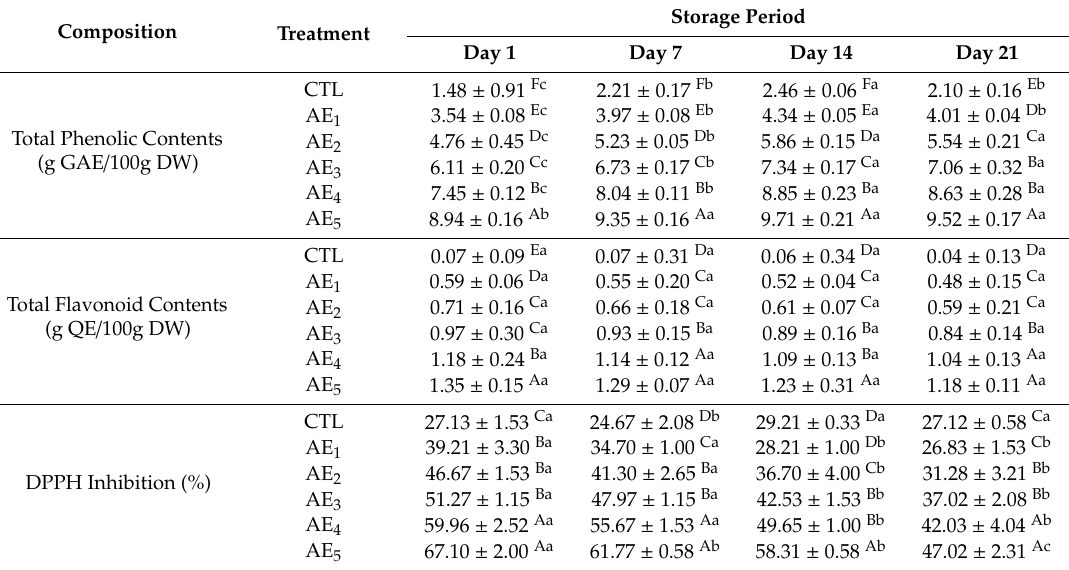
Table 3. Total phenolic contents of probiotic yoghurt with addition of